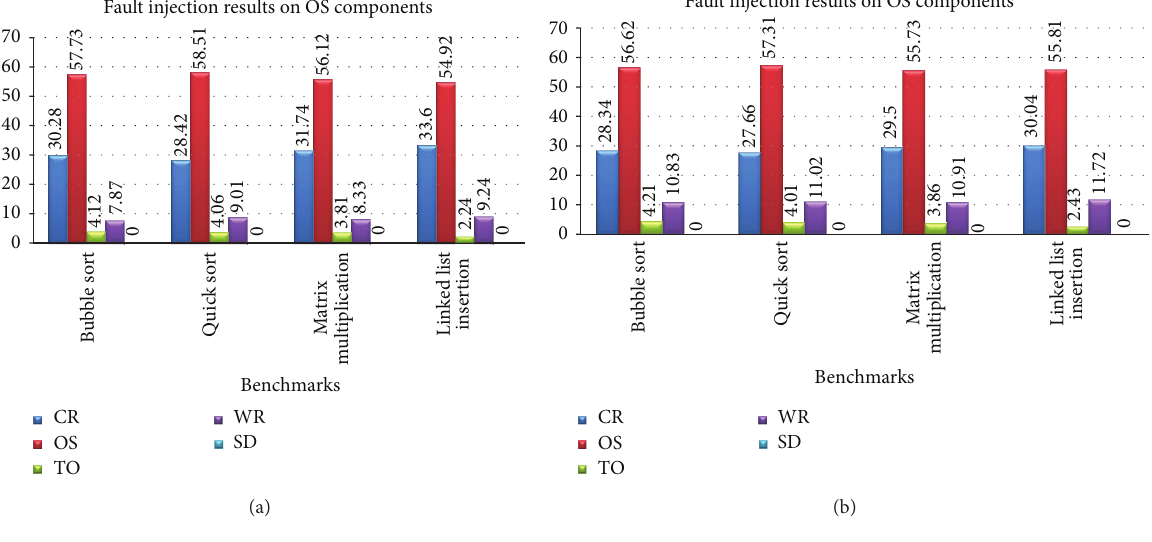
Figure 6: The average results from Tables 5 and